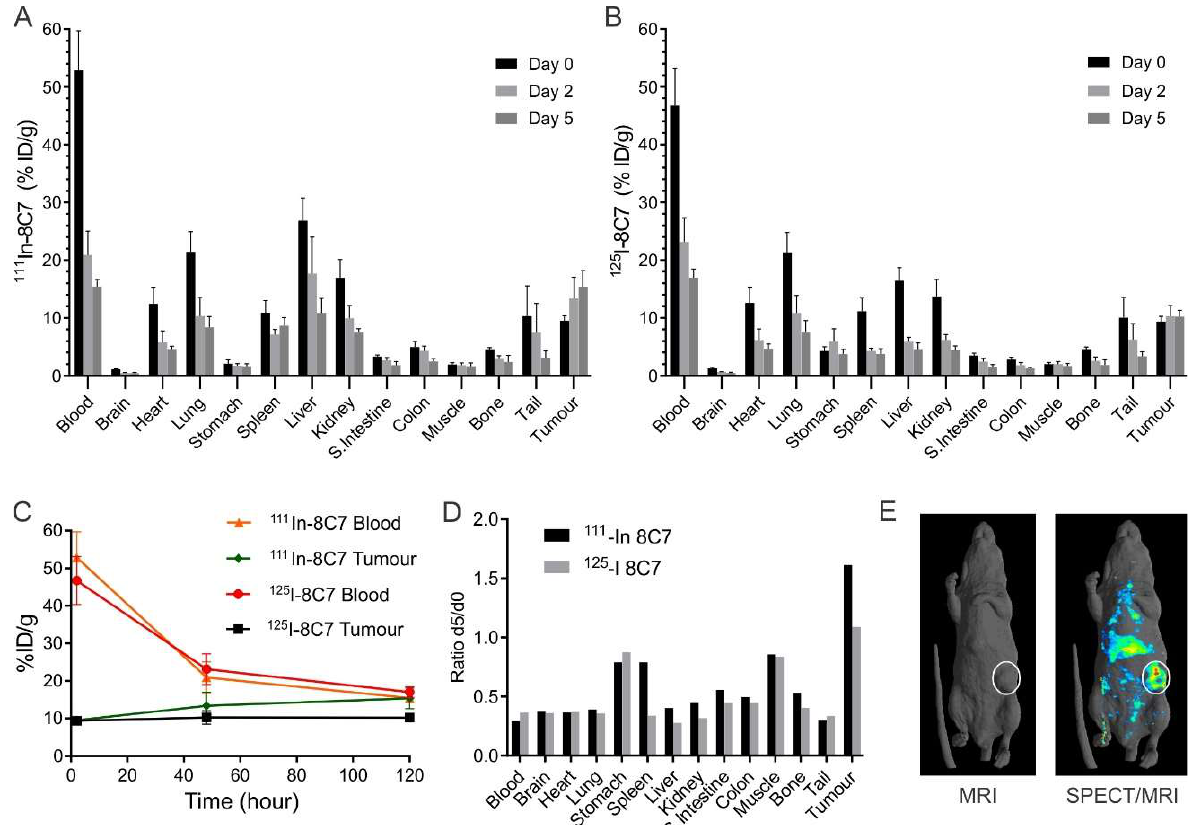
Figure 1. Biodistribution of radiolabelled 8C7 in mice with subcutaneous LIM1215 tumours. ( A – C ) Mice ( n = 5) were injected with a mix of 111 In- and 125 I-labelled 8C7, and blood and tissues were recovered after 2 h, 48 and 120 h (Day 0, 2 and 5) for determination of radioactivity, expressed as mean fraction of the injected dose/gram tissue (% ID/g, ±SD). ( D ) The data in A and B showing radiolabelled 8C7 retained in tumour versus normal tissues at Day 5 relative to Day 0. ( E ) Representative images of a mouse with subcutaneous tumour (circled), injected with 111 In-8C7 and imaged (Day 2) by surface rendered MRI and gamma camera SPECT scan.